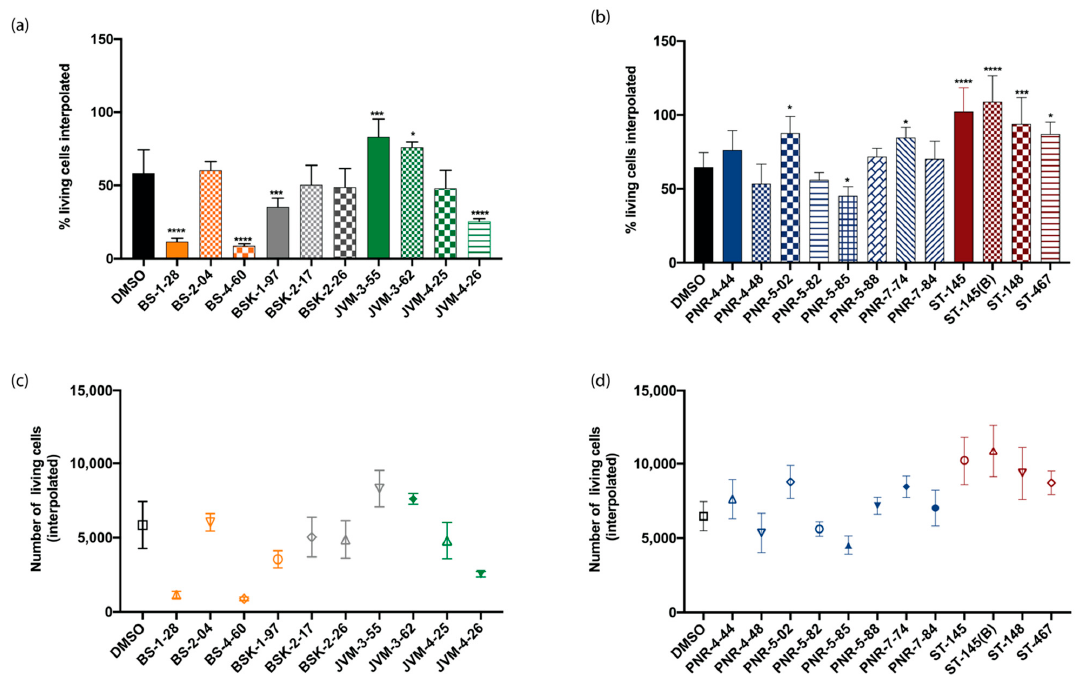
Figure 2. Determination of cytotoxicity on a U-251 MG cell 3-D model with percentage of living cells interpolated for ( a ) the first series of compounds tested: BS, BSK, and JVM, and for ( b ) the second series of compound tested: PNR and ST. Respective numbers of living cells interpolated for ( c ) the first series of compounds tested: BS, BSK, and JVM, and for ( d ) the second series of compounds tested: PNR and ST. Statistical analysis for significance determination was done using one-way ANOVA with the control (DMSO) as the comparative model with the Dunnett model, ns (non -significant) for adjusted p > 0.05,* for adjusted p ≤ 0.05, *** p ≤ 0.001, and **** p ≤ 0.0001. For each experiment, n = 3. Table 2. Summary of compound cytotoxicity and invasion inhibition. Significance is compared to control (DMSO) with ns: non-significant, (-): higher cytotoxicity or death induced than the control, (=): no difference compared to control, ( + ): higher viability of percentage of living cells than the control. Significance was established for cytotoxicity and invasion assay independently with two-way ANOVA with the control (DMSO) for 48 h of invasion, control as the comparative model with the Dunnett model, ns (non -significant) for adjusted p > 0.05,* for adjusted p ≤ 0.05, ** for adjusted p ≤ 0.01, *** p ≤ 0.001, and **** p ≤ 0.0001. For each experiment, n = 3.